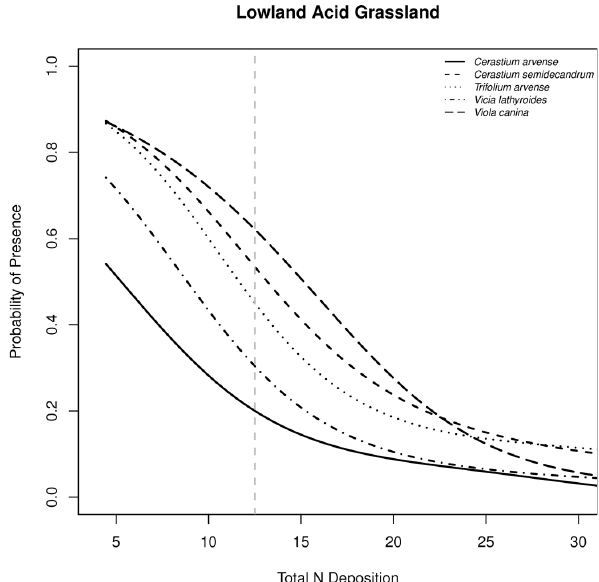
Fig. 4. Change in probability of presence for species showing sta- tistically significant relationships to N deposition in lowland acid grasslands in the Vascular Plant database against increasing total inorganic N deposition (kgNha − 1 yr − 1 ) . The dashed grey line in- dicates the midpoint of the critical load range for acid grasslands as defined by Bobbink and Hettelingh